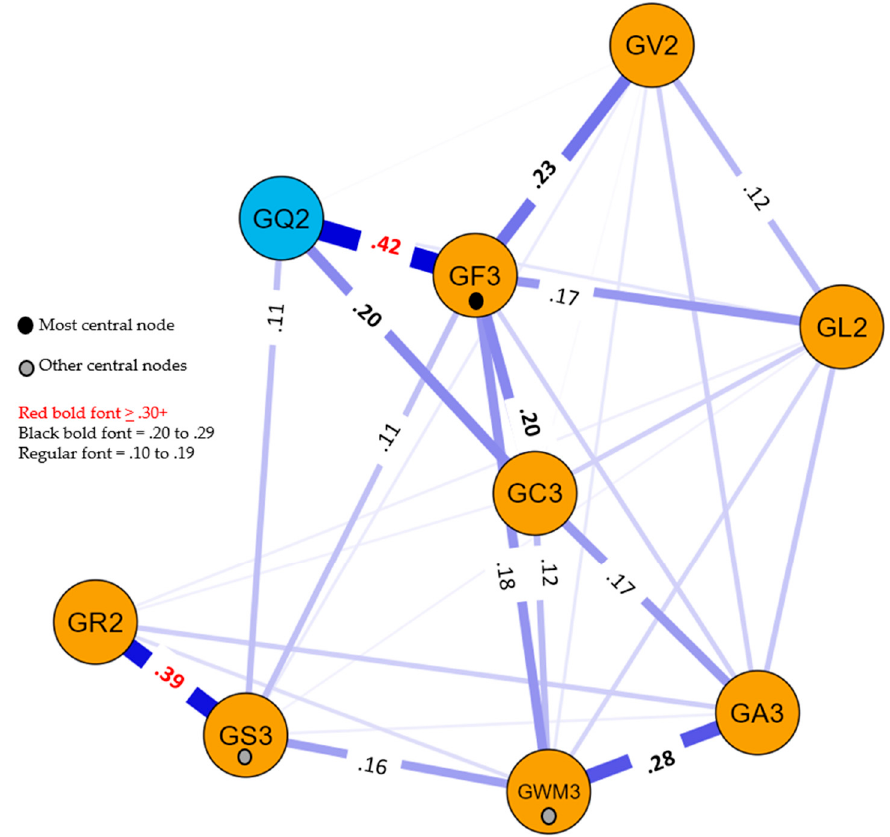
Figure 2. Weighted undirected network structure of eight WJ III CHC cognitive composite measures and one math (GQ2) composite measure in the cognitive–math network model. Note. Numbers are the edge weights greater than or equal to .10 (see key for three-category system of relative weight size). The three most central nodes are designated by black and gray circles on nodes (see manuscript text).